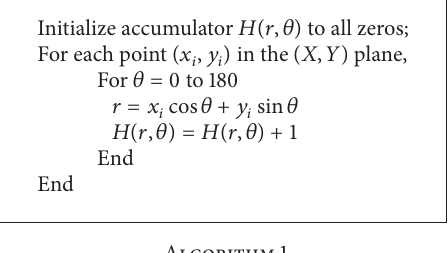
Initialize accumulator 𝐻(𝑟,𝜃) to all